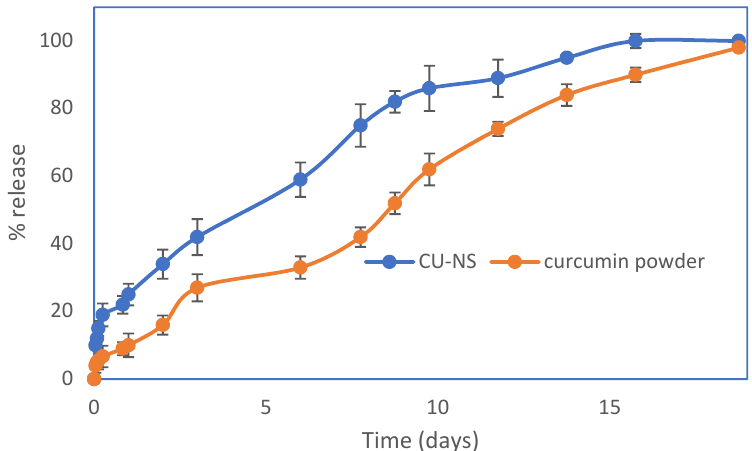
Figure 5. In vitro dissolution/release of curcumin powder and CU-NS in 10% w/v aqueous Tween 80 media at 37 °C. Means ± S.D., n = 3.